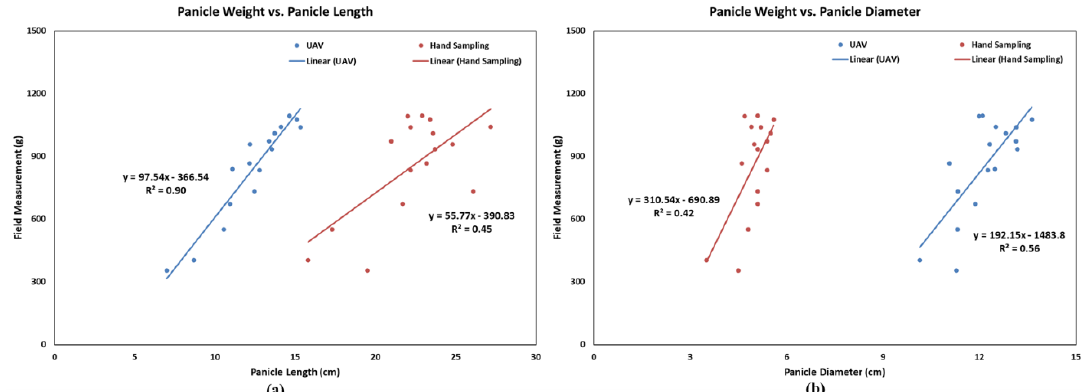
Figure 6. Relationships between yield versus average panicle ( a ) length and ( b ) diameter of selected varieties; field and UAV measurements are shown in red and blue,